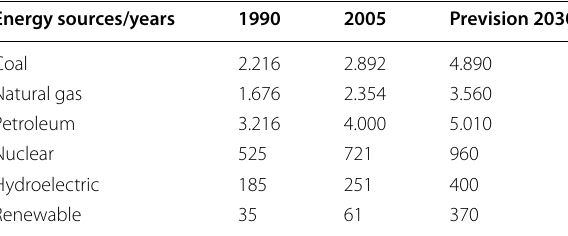
Table 1 World energy demand on milion tonne oil equivalent. Source: Ranci